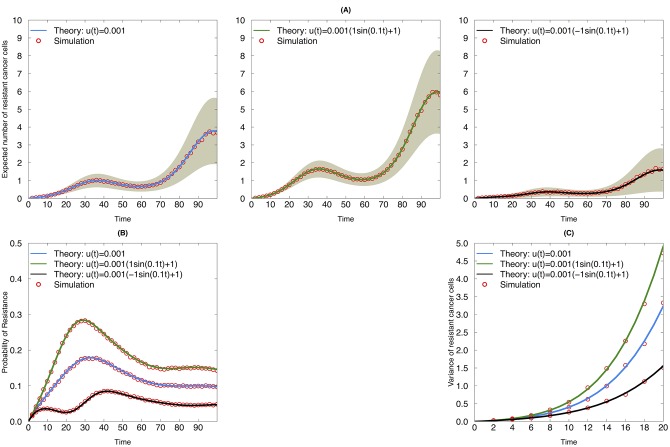
Evolutionary dynamics of sensitive and resistant clones during continuous therapy with different mutation dynamics.(A) Expected number of resistant cancer cells as a function of time during continuous therapy. Blue line: mutation rate is constant during treatment; black line: mutation rate increases with drug dose; green line: mutation rate decreases with drug dose. Red circles: simulation results. Grey shaded area indicates one analytic standard deviation from the analytic mean. (B) Probability of resistance as a function of time during continuous therapy. (C) Variance of resistant cancer cells as a function of time during continuous therapy. The following parametrizations were used for both simulation and analytic approximations: A
s = 0.05, B
s = 0.1, C
s = 0.005, A
r = 0.05, B
r = 0.12, C
r = 0.002, and θ = 0.10. The values for A
u and B
u are denoted in the panels for each corresponding scenario.